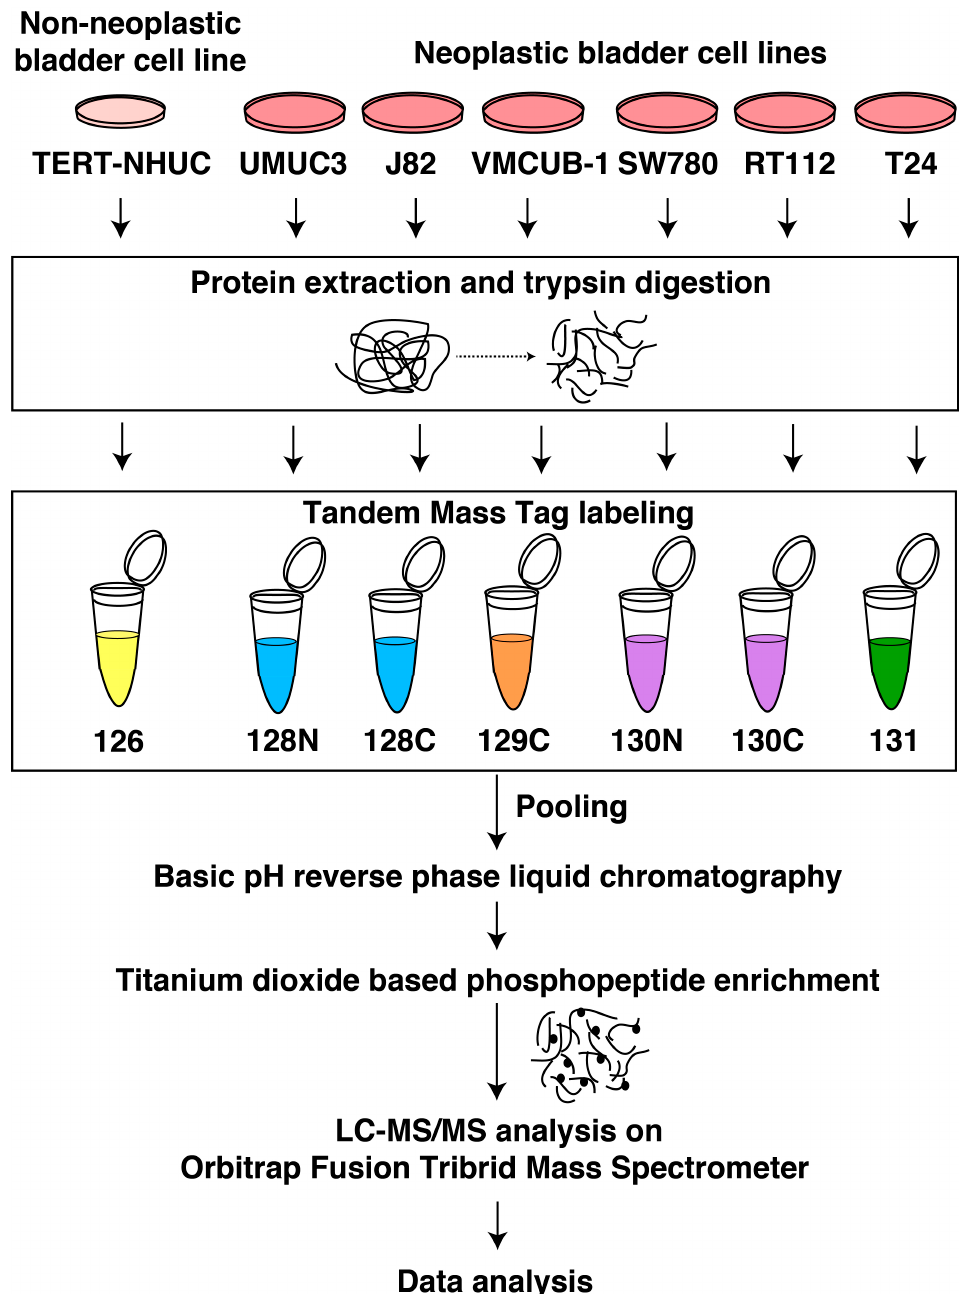
Figure 2. Workflow illustrating the quantitative phosphoproteomics analysis of bladder carcinoma cell lines. For sample processing, proteins were extracted from the bladder carcinoma and non-neoplastic cell lines and digested using trypsin. Each cell line was tagged using the tandem mass tags TMT labeling kit and lyophilized and enriched using the phosphopeptide enrichment protocol (titanium dioxide enrichment). The samples were run on Orbitrap Fusion Tribrid Mass Spectrometer and MS2-based quantitation was achieved. The files were searched against Mascot and Sequest HT search engines. PhosphoRS node was used for the phosphosite assignment. Data was acquired in technical replicates.